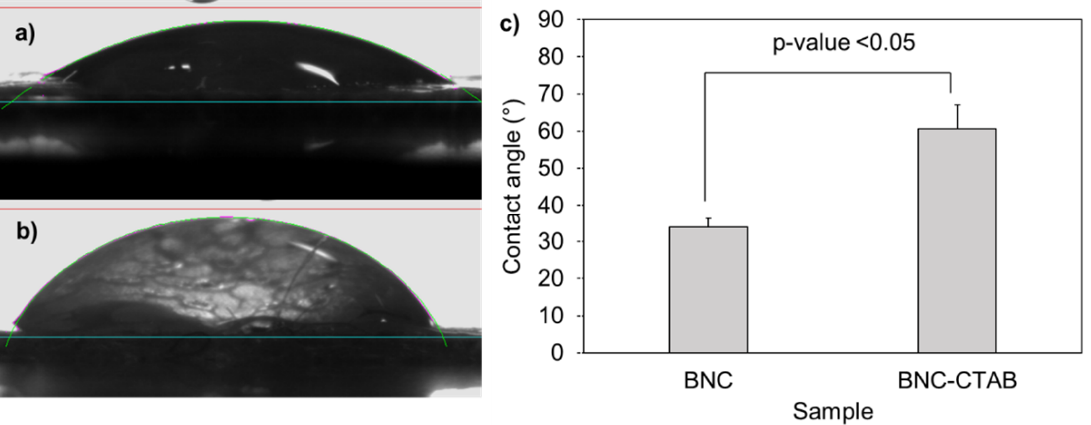
Figure 3. Contact angle experiments: ( a ) drop of deionized water in BNC; ( b ) drop of deionized water in BNC-CTAB; ( c ) average of contact angles. The sample groups were statistically different with p values < 0.05.